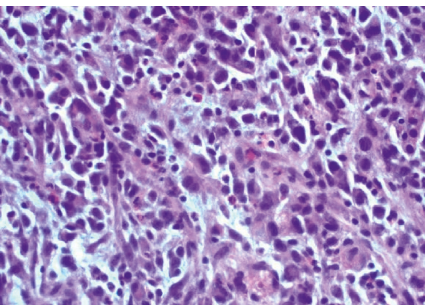
Figure 9: Liver parenchyma infiltrated with large spindle cells with abundant foamy clear to eosinophilic cytoplasm and large pleo- morphic nuclei with abundant nucleoli. Mixed inflammatory in- filtrates, consisting of neutrophils, eosinophils, lymphocytes, and plasma cells.